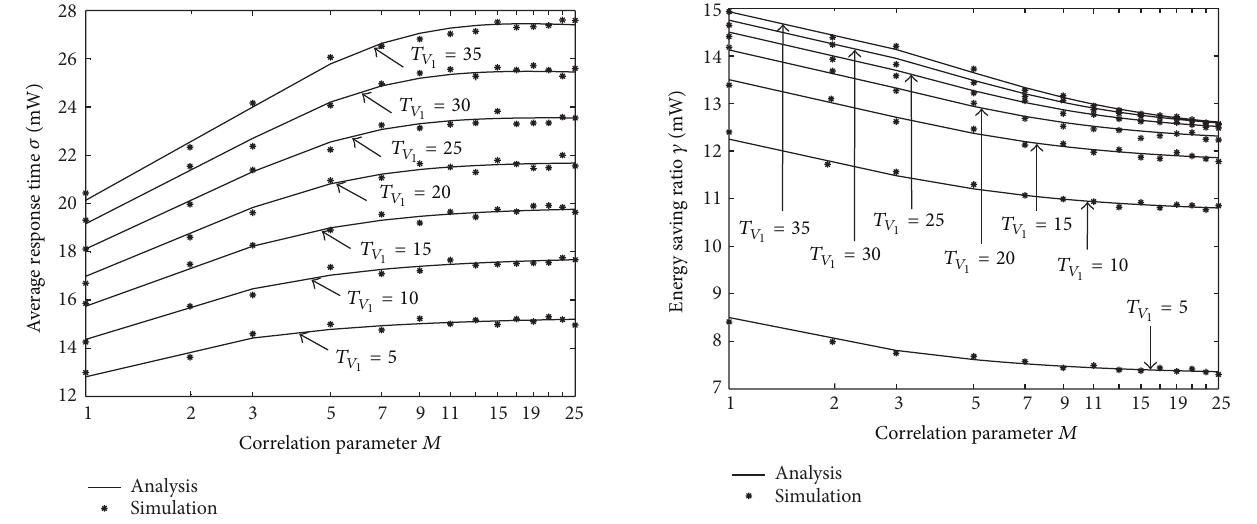
Figure 6: Energy saving ratio 𝛾 versus correlation parameter 𝑀 .